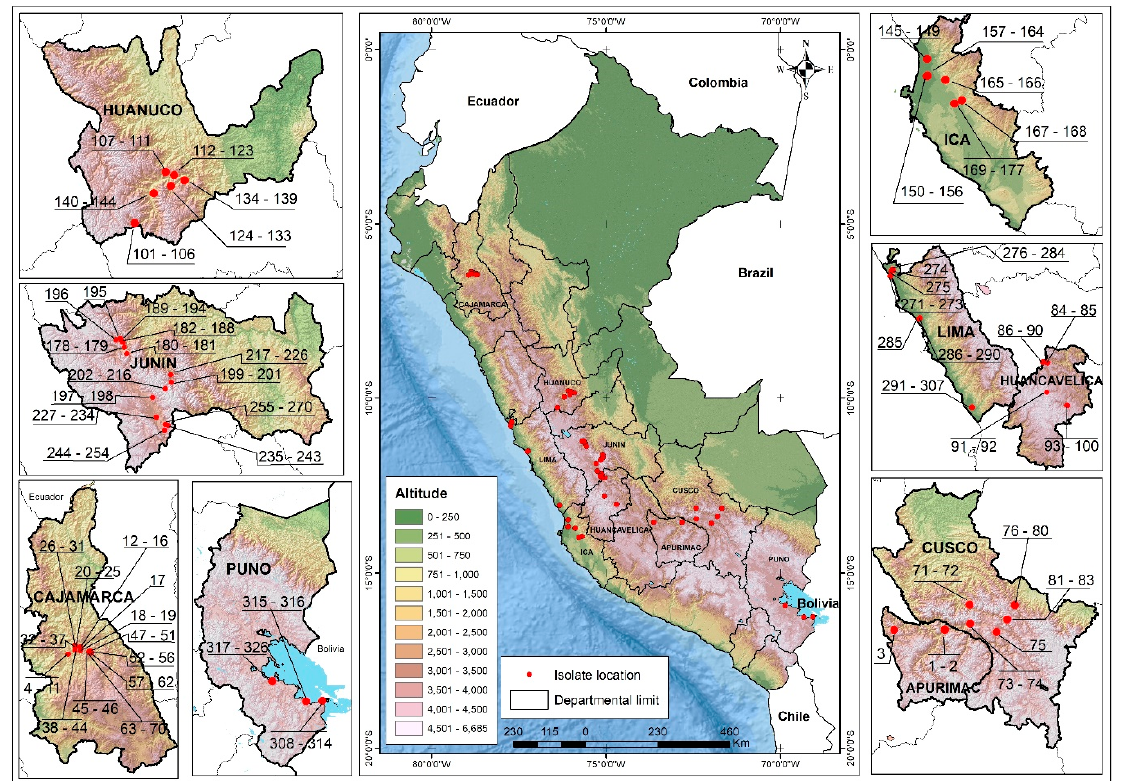
Figure 1. Map of sample collection sites in the Andean Highlands showing where potato leaf samples were obtained. Peru’s Andean highlands are shown as brown, the country ′ s coastal desert and Amazonian jungle regions as green and surrounding countries as white. The red dots marked on the main map represent the locations sampled, and the names marked on it are those of the countries’ regional departments sampled (black lines are departmental boundaries). The red dots marked on the individual department maps clustered on either side show each collection site, and the numbers indicate each individual infected sample collected. Individual collection sites are numbered (Supplementary Materials (SM) File S1, column C). The names of the Departments also provide the first three letters of each isolate name (SM File S1, column